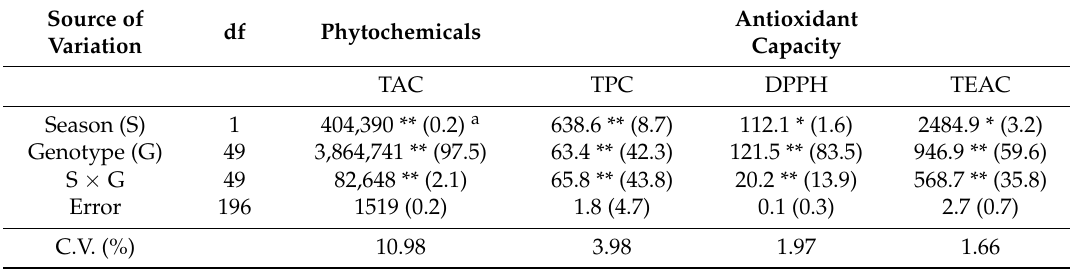
Table 1. Mean squares for the total anthocyanin content, total phenolic content and antioxidant capacity in the tassel of fifty waxy corn genotypes evaluated across two